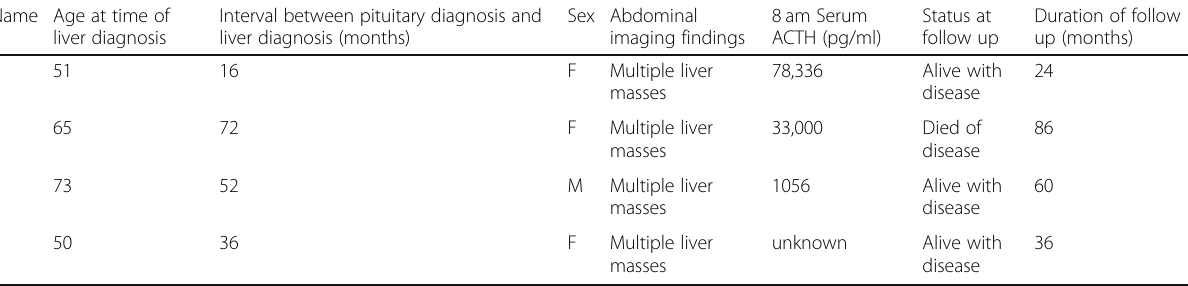
Table 1 Summary of the clinical characteristics of the patients with pituitary carcinomas presenting as multiple liver masses Name Age at time of Interval between pituitary diagnosis and liver diagnosis liver diagnosis